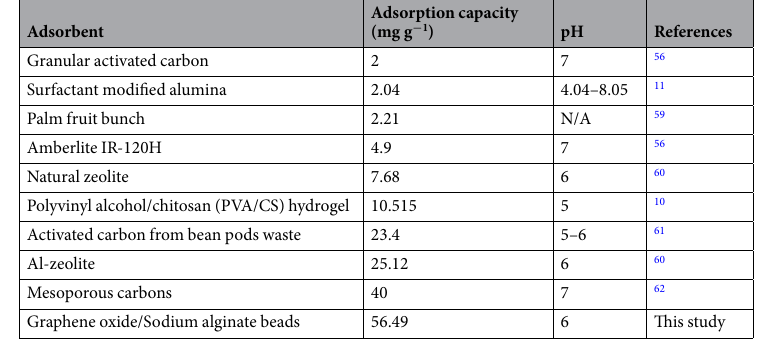
Table 4. Comparison of adsorption capacity of Mn(II) onto various